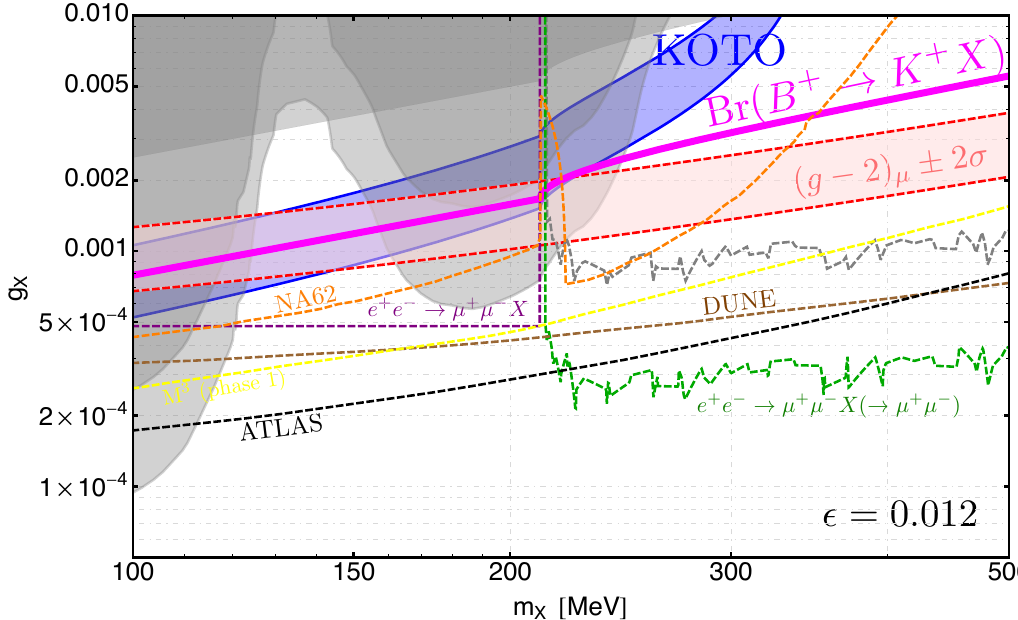
Figure 6. The sensitivity limit expected in future experiments, for model II with a ( L (cid:22) (cid:0) L (cid:28) ) + (cid:15) ( B 3 L (cid:28) ) gauge boson X . All solid lines belong to B 3 coupling and dashed lines to L (cid:22) coupling. (cid:0) Blue shaded band is the region for KOTO desired Br( K 0 (cid:25) 0 X ) value. Red shaded band is the L ! required value for ( g 2) (cid:22) . From the existing upper limits of Belle and BaBar, we show the Belle (cid:0) II (with the data of 50 ab (cid:0) 1 integrated luminosity) expected upper limits from i) Br( B + K + X ) ! (magenta) for hadronic coupling and muonic force searches using ii) 4 (cid:22) channel (green) and iii) (cid:22) (cid:0) (cid:22) + X ( inv.) channel (purple) [36, 68]. We also show the limit from for (cid:23) -trident production ! at DUNE (brown) [38], Kaon decays ( K + (cid:22)(cid:23)X ) at NA62 (orange) [37], M 3 (yellow) [39] and ! ATLAS (black) [69] for comparison. We set (cid:15) = 0 : 012 as an example case. VLQs, ii ) gauged L (cid:22) L (cid:28) + (cid:15) ( B 3 L (cid:28) ) with mixing of two gauge bosons. Both (cid:0) (cid:0)